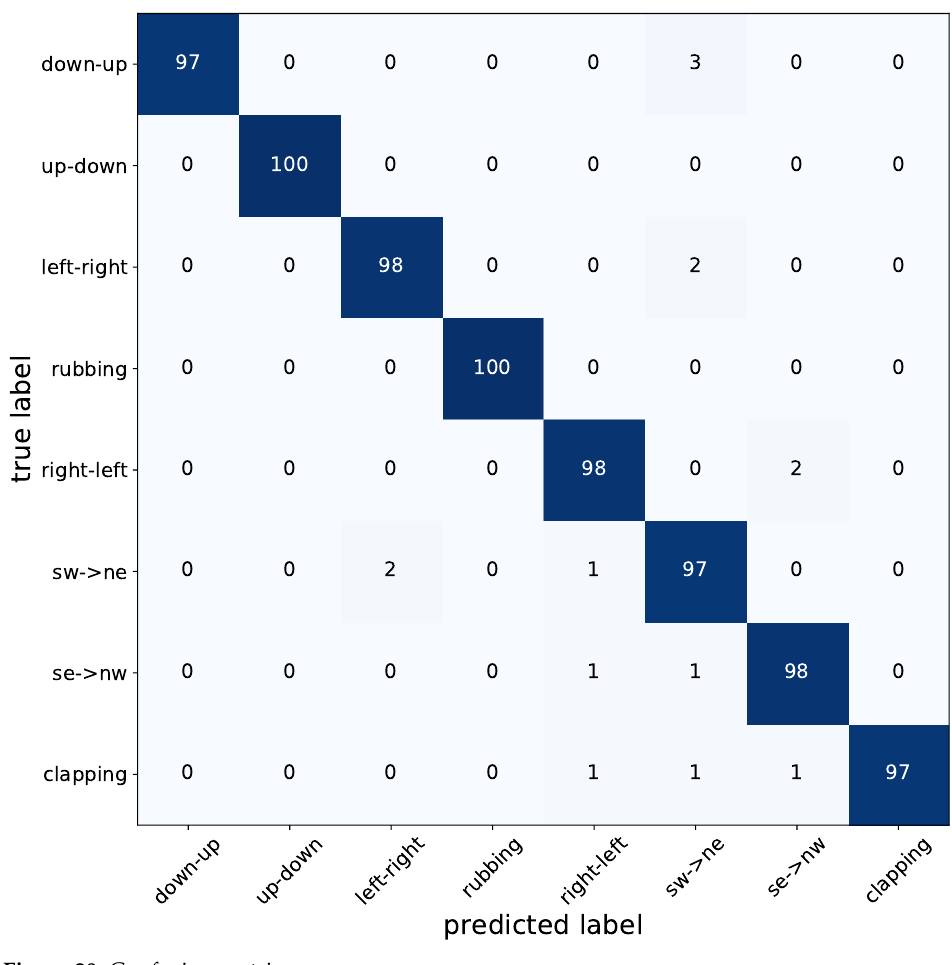
Figure 20. Confusion